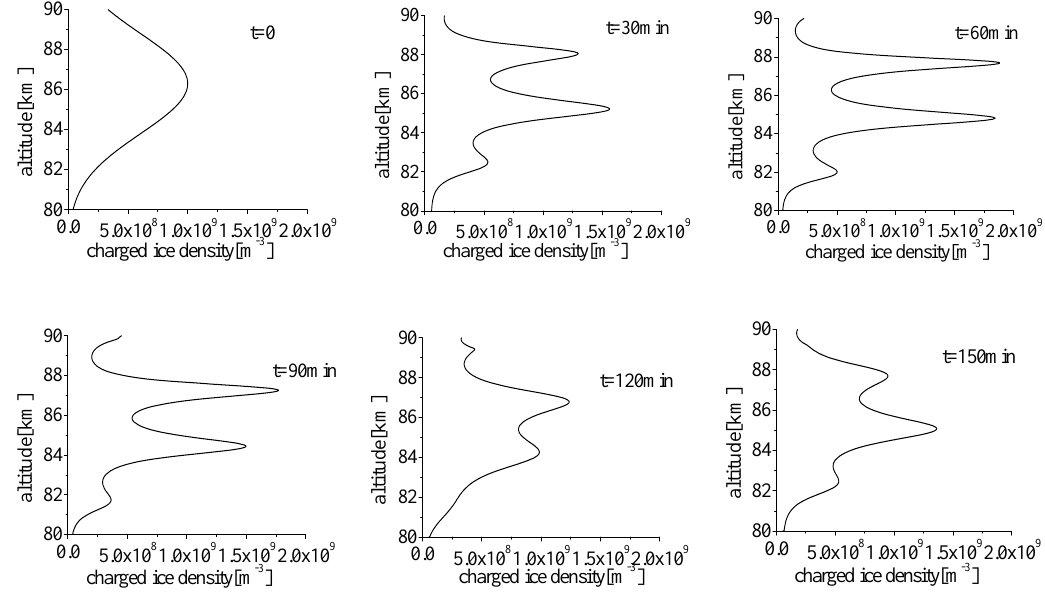
Fig. 1. The number density profiles evolution before and after modulation by the gravity waves. The time interval is 30min ( t = 0, 30, 60, 90, 120, 150min) for each panel. With the vertical gravity wavelength of 3km an intrinsic period of